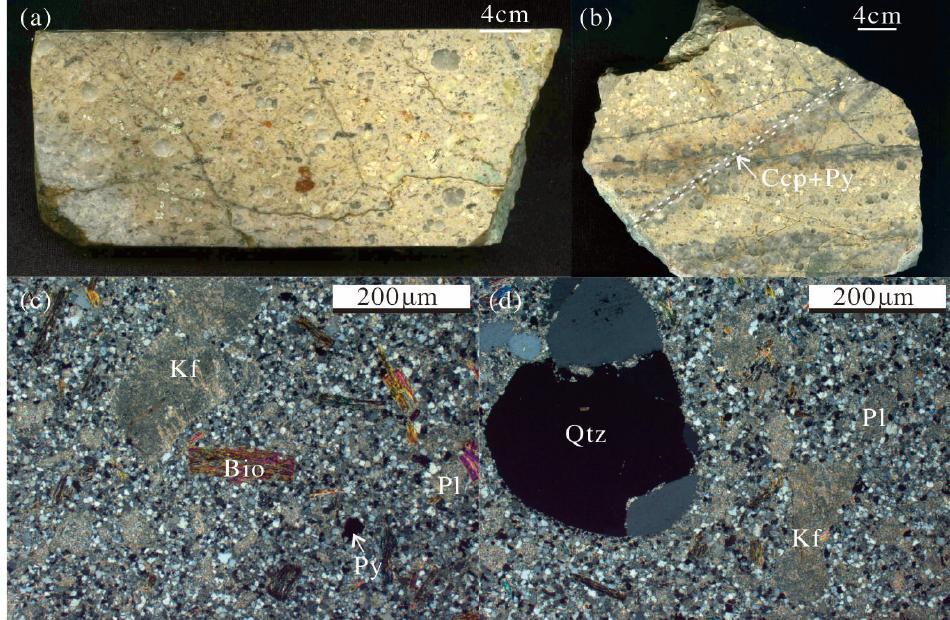
Figure 2. Pictures and photomicrographs of the Dongxiang granodiorite porphyry. ( a , b ) Hand specimens of Dongxiang granodiorite porphyry samples ZK6701 and DT026; ( c , d ) photomicrographs showing the mineralogy of the two sample porphyries from the area. Abbreviations: Pl—plagioclase; Kf—alkaline feldspar; Bio—biotite; Qtz—quartz.